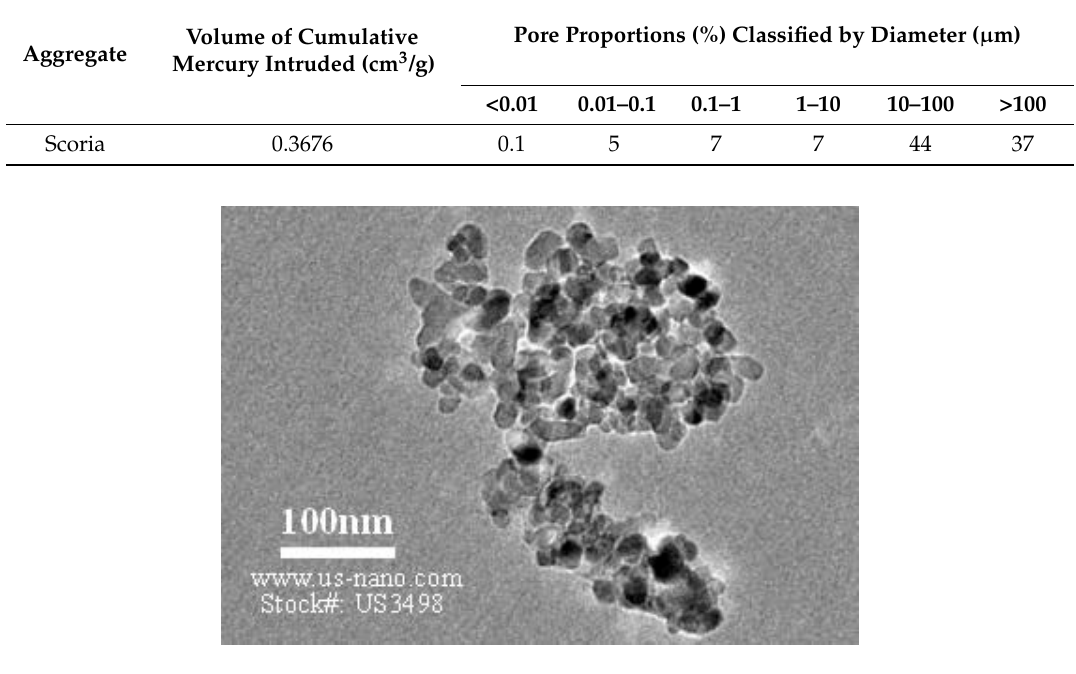
Figure 10. Transmission electron microscopy (TEM) image of nano-titanium.